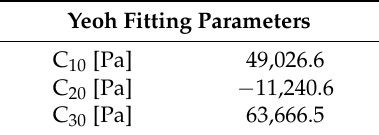
Table 2. Yeoh material constants for thoracic aortic tissue from uniaxial tensile testing by [10].